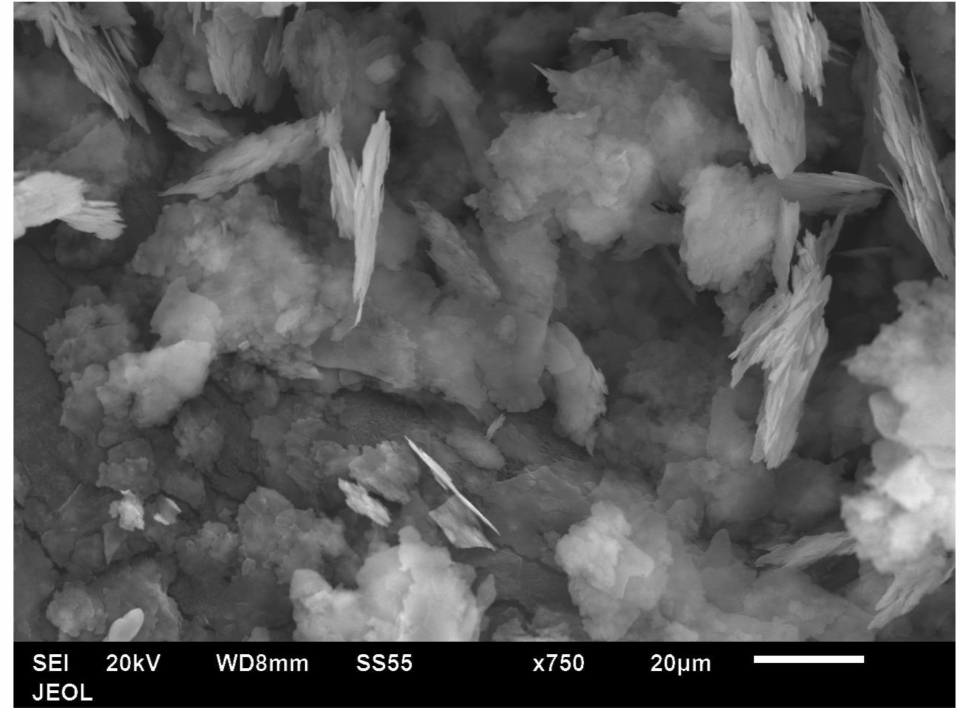
Figure 2. Low-magnification SEM image of Al powder (Nanografi, Germany) shows a platy material with few flakes lying edgewise. However, due to clumping, the platelet thickness cannot be estimated